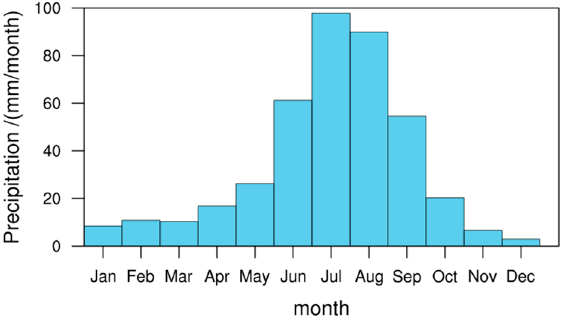
Figure 3. Monthly accumulated precipitation on the SRTR (averaged from 2001 to 2019).